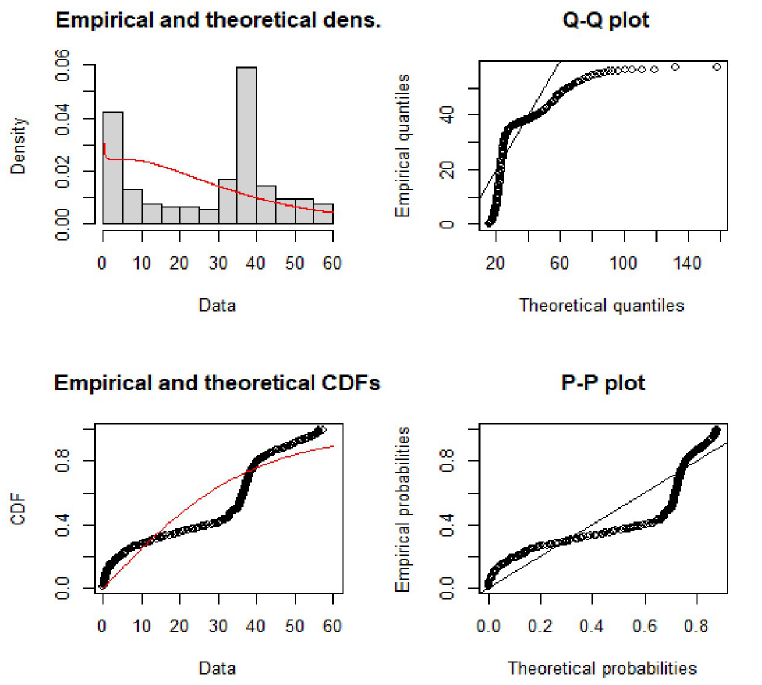
Fig 7. Theoretical and empirical PDF and CDF with Q-Q plot and P-P plot for NFW.